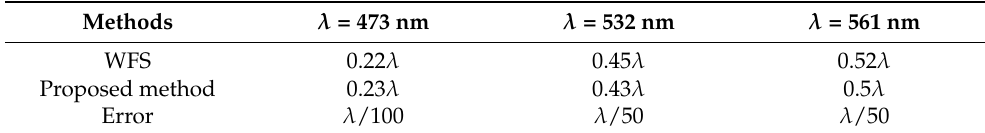
Table 1. Values of the obtained aberrations.